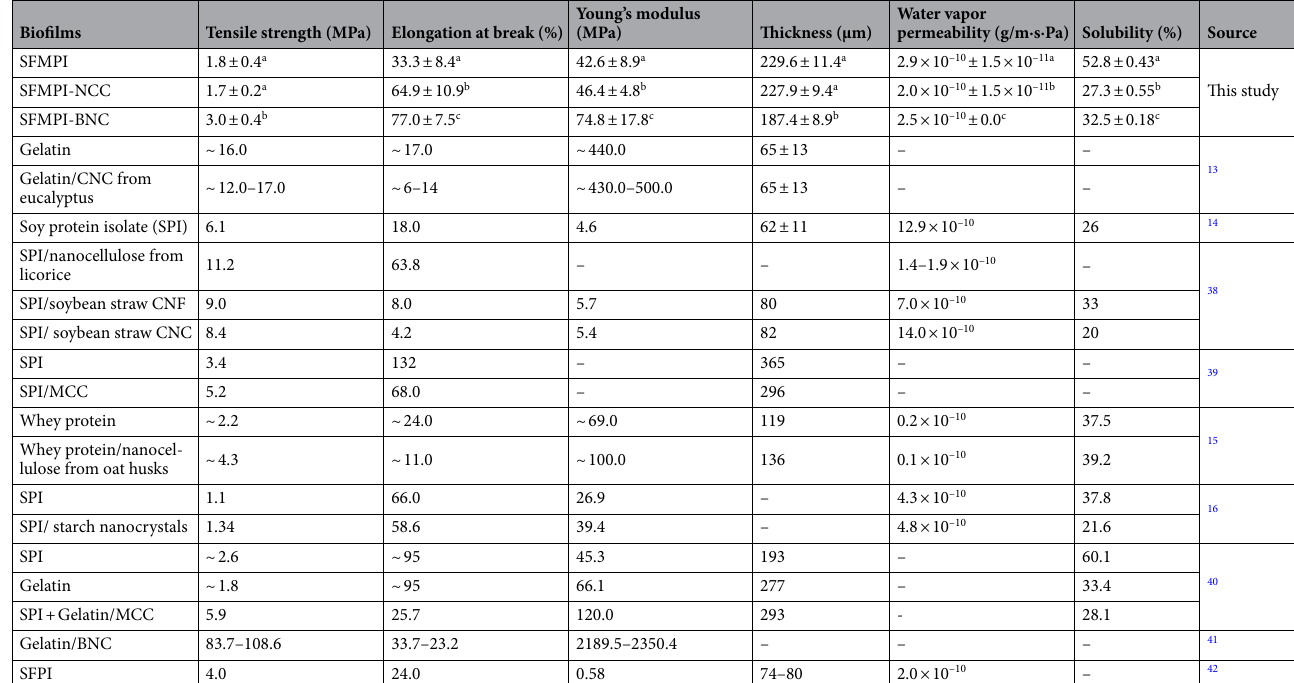
Table 1. Mechanical and physical properties of SFMPI-, SFMPI-NCC- and SFMPI-BNC-based biofilms compared to the properties of renewable cellulose or commercial cellulose derivatives based films, cited in the literature. Different superscript letters within same column indicate statistically significant differences ( p <